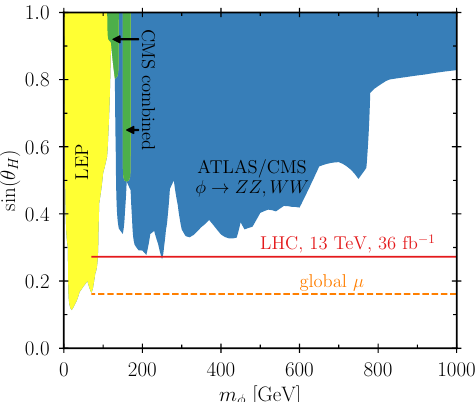
Figure 9 . Exclusion bounds on the mass of the lepton number breaking scalar (cid:30) and the Higgs mixing angle (cid:18) H from direct searches (colored regions) and signal strength measurements (colored lines).